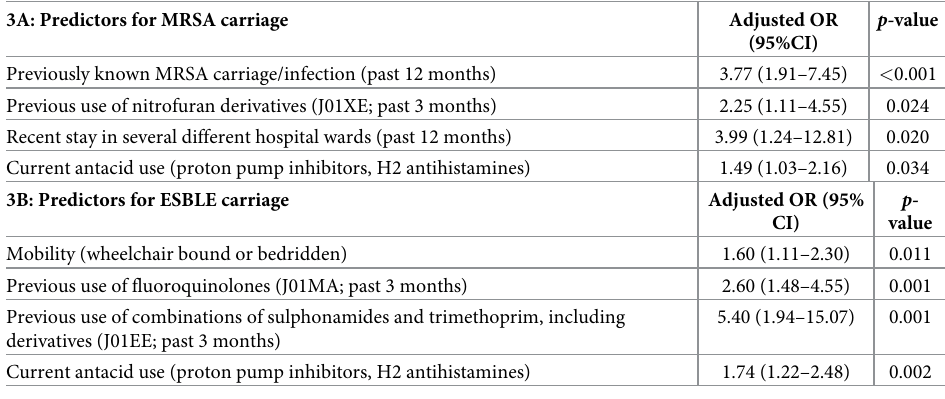
Table 5. Multiple logistic regression analysis of individual risk factors for carriage of MRSA (3A), of ESBLE (3B) among a random sample of residents screened within 29 Belgian nursing homes,